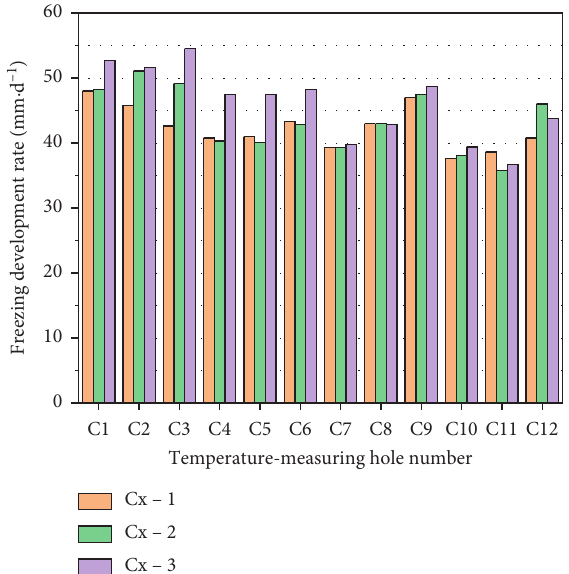
Figure 10: Distance from each measuring point to the nearest freezing